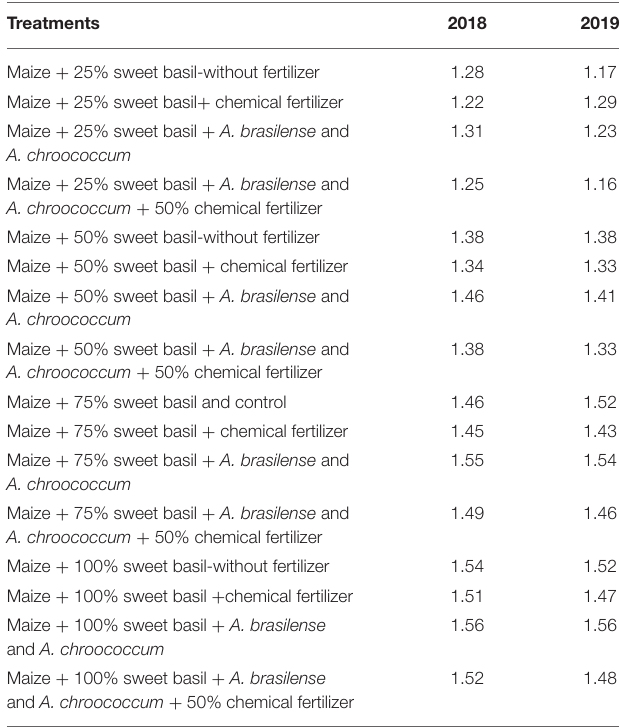
TABLE 6 | Land equivalent ratio (LER) in intercropping treatments of maize with sweet basil and N 2 fixing bacteria (2018 and 2019).